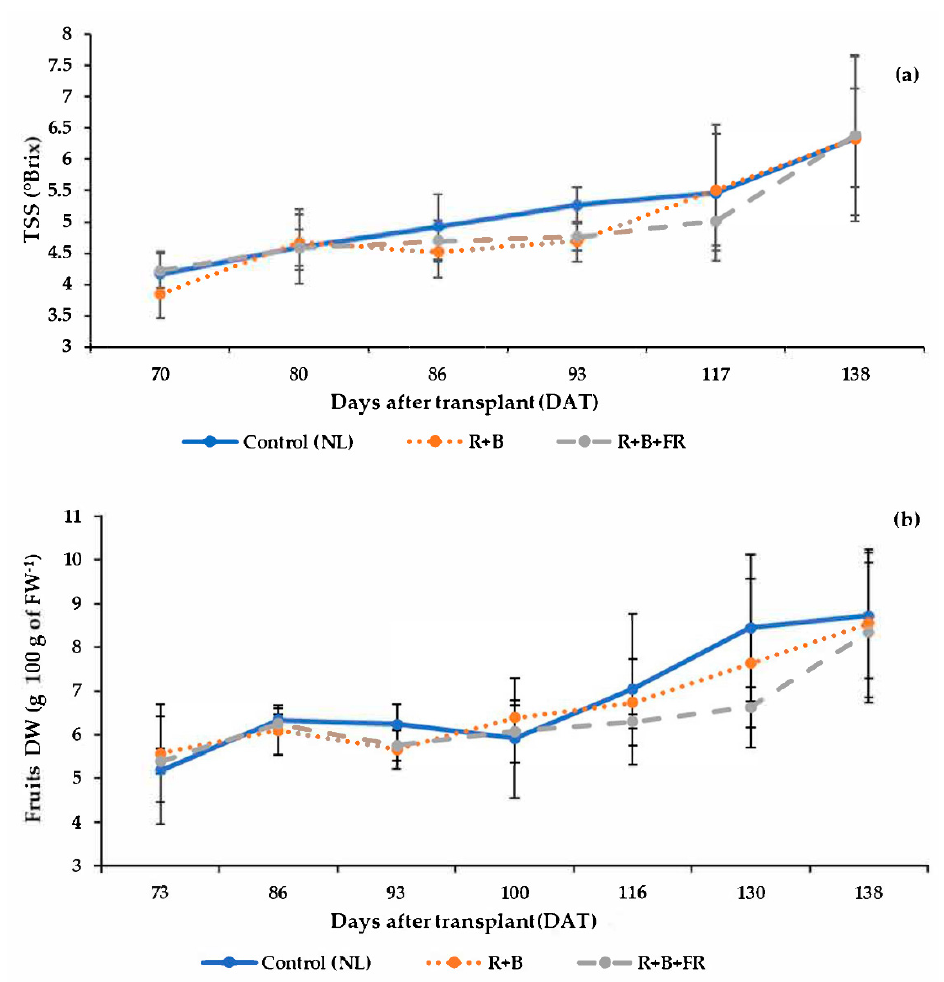
Figure 5. Total soluble solids (TSS) ( a ) and fruit dry weight (DW) ( b ) of plants grown under control (NL), R + B + FR, and R + B light conditions. Values are average of three replications. Vertical bars represent ± standard deviation of mean values.